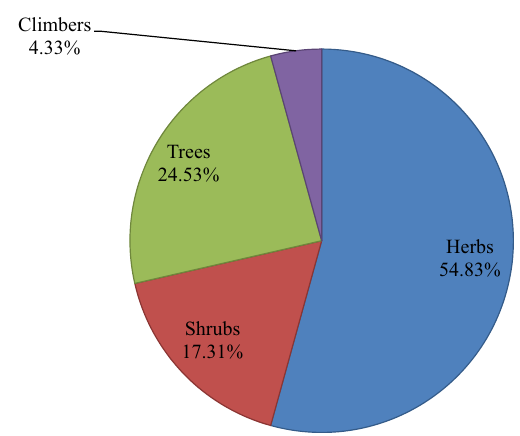
Figure 3: Growth forms of medicinal plants.